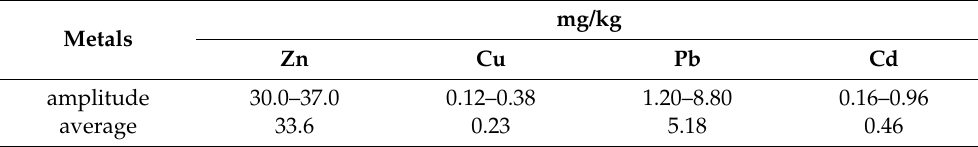
Table 1. Heavy metal concentrations in bottom sediment of the Kapshagay Reservoir.